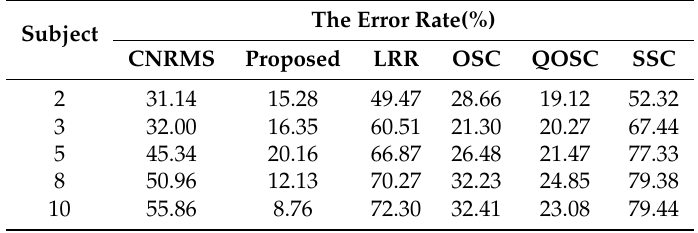
Table 2. Expression clustering error (%) on